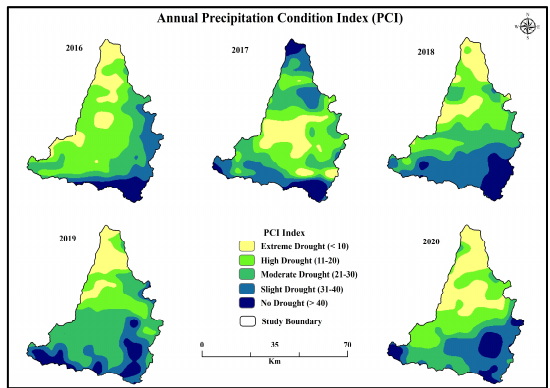
Figure 9: Annual Precipitation Condition Index of 2016 to 2020